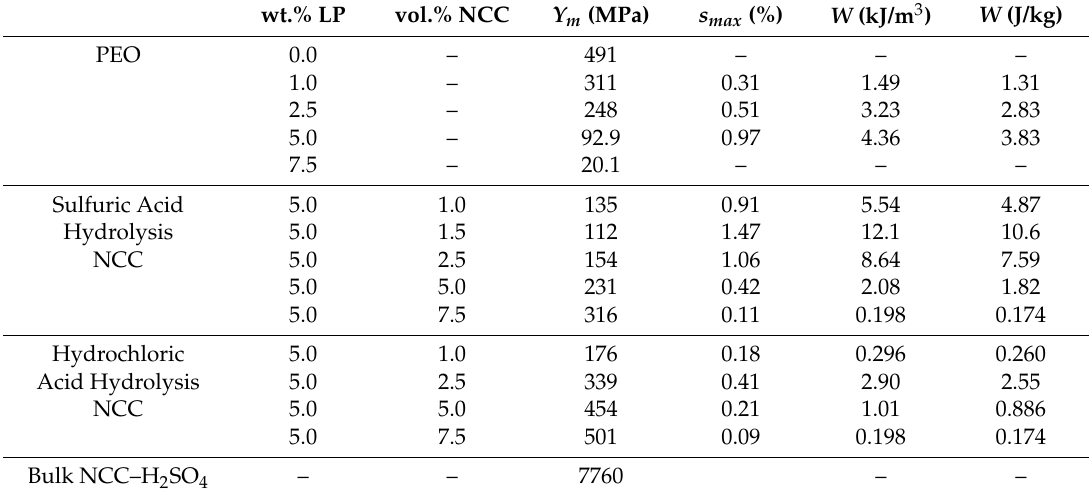
Table 1. Elastic modulus and energy density data for various IPMC